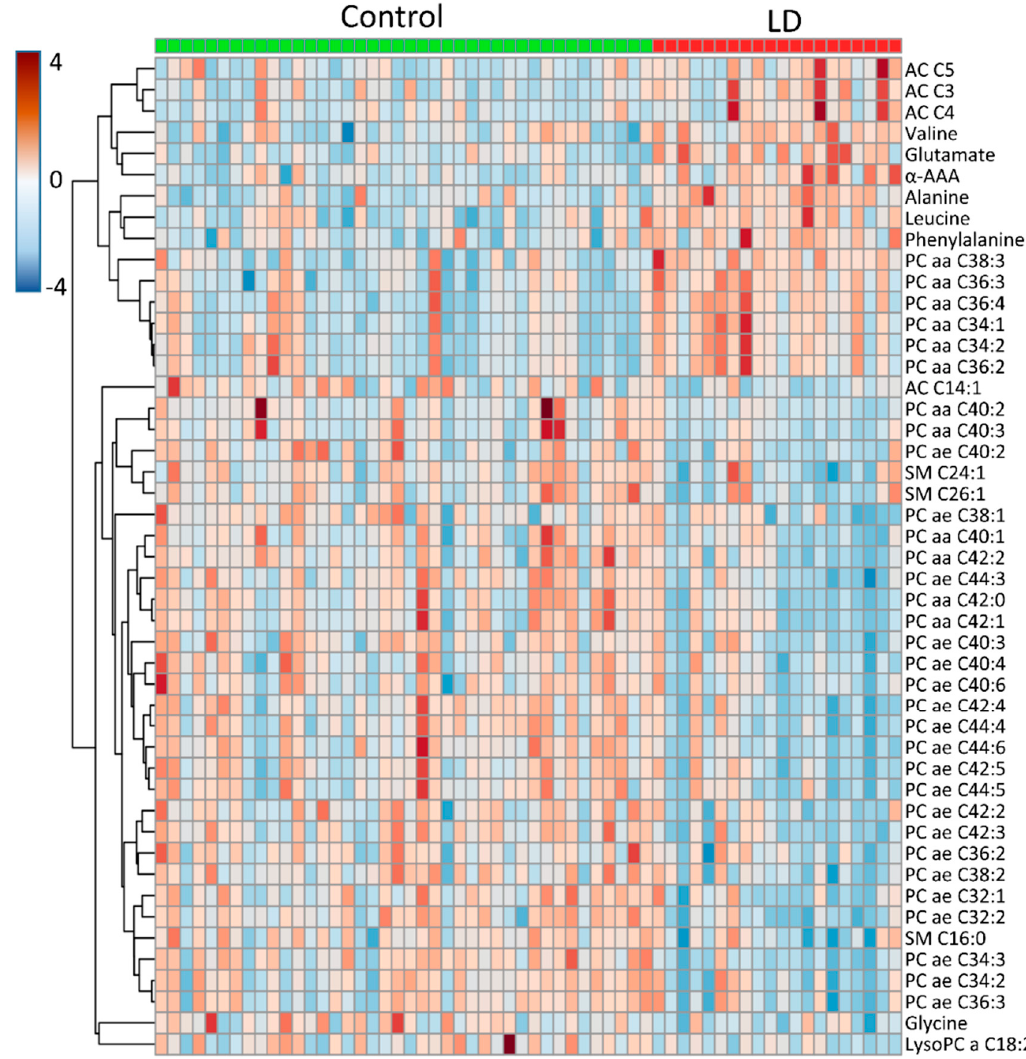
Figure 4. Heat map of 47 metabolites were significantly different between control and lipid disorder (LD) group. After adjusting for age, hypertension, CAD, stroke and CKD, 47 of the 154 metabolites were significantly different between the control and LD groups, with a false discovery rate (FDR) to correct the p -value ( q < 0.05). Each column represents a plasma sample and each row represents the level of a metabolite.